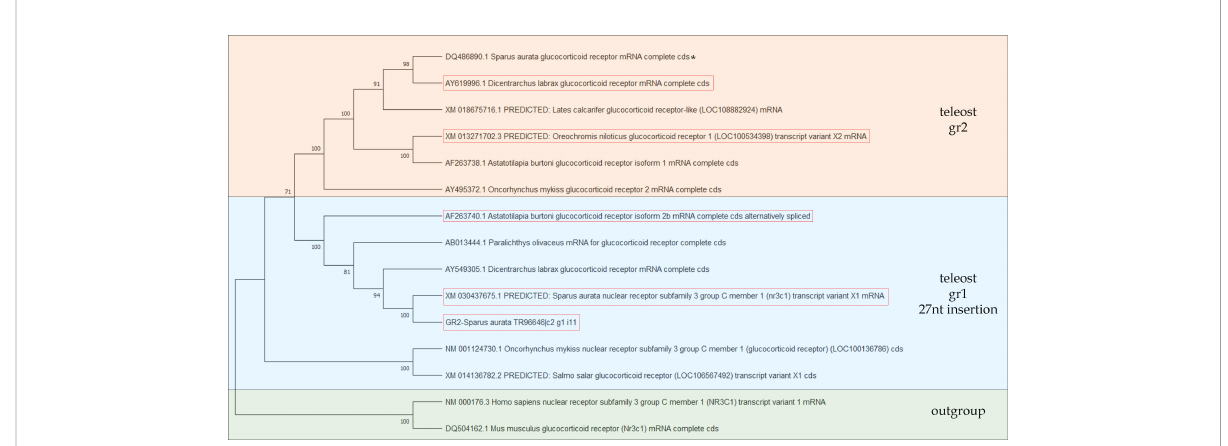
FIGURE 4 Phylogenetic analysis of gr1 and gr2 sequences for different species of teleost fi sh. The image represents the clades for teleost glucocorticoid receptor 2 ( gr2 ; orange), teleost gr1 ( gr1 ; light blue) that includes the 27-nucleotide (27-nt) insertion, and the outgroup (green). The sequences associated with gr2 are detailed below according to the order of presentation (from top to bottom) in the alignment, and indicating the fi sh species and the Nucleotide accession number [(NCBI), represented on the left column of alignment]: DQ486890.1 for gilthead sea bream ( Sparus aurata ; de fi ned by Acerete et al. (2007) as glucocorticoid receptor); AY619996.1 for European sea bass ( Dicentrarchus labrax ); XM_018675716.1 for Asian sea bass ( Lates calcarifer ); XM_013271702.3 for Nile tilapia ( Oreochromis niloticus ); AF263738.1 for Burton ’ s mouth- brooder ( Astatotilapia burtoni ); and AY495372.1 for rainbow trout ( Oncorhynchus mykiss ). The sequences associated with gr1 (from top to bottom) were the AF263740.1 for Burton ’ s mouth-brooder ( A. burtoni ); AB013444.1 for Japanese fl ounder ( Paralichthys olivaceus ); AY549305.1 for European sea bass ( D. labrax ); XM_030437675.1 (99% identity with our sequenced PCR product) and GR2-Sparus aurata TR96646|c2_g1_i11 [described in Tsalafouta et al. (2018)] for gilthead sea bream ( S. aurata ); NM_001124730.1 for rainbow trout ( O. mykiss ); and XM_014136782.2 for Atlantic salmon ( Salmo salar ). The values at branch nodes indicate the percentage of trees in which the associated taxa clustered